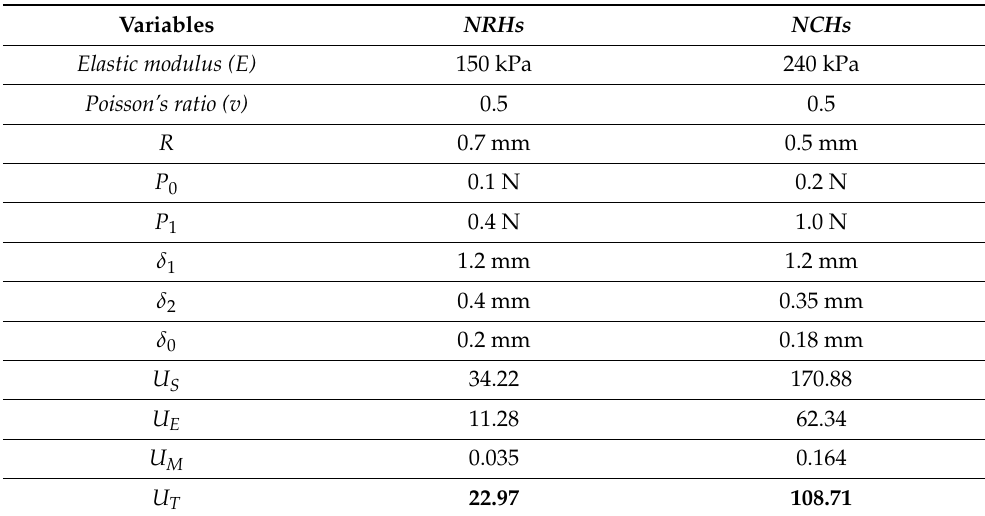
Table 2. Variables used for total energy calculations of hydrogel